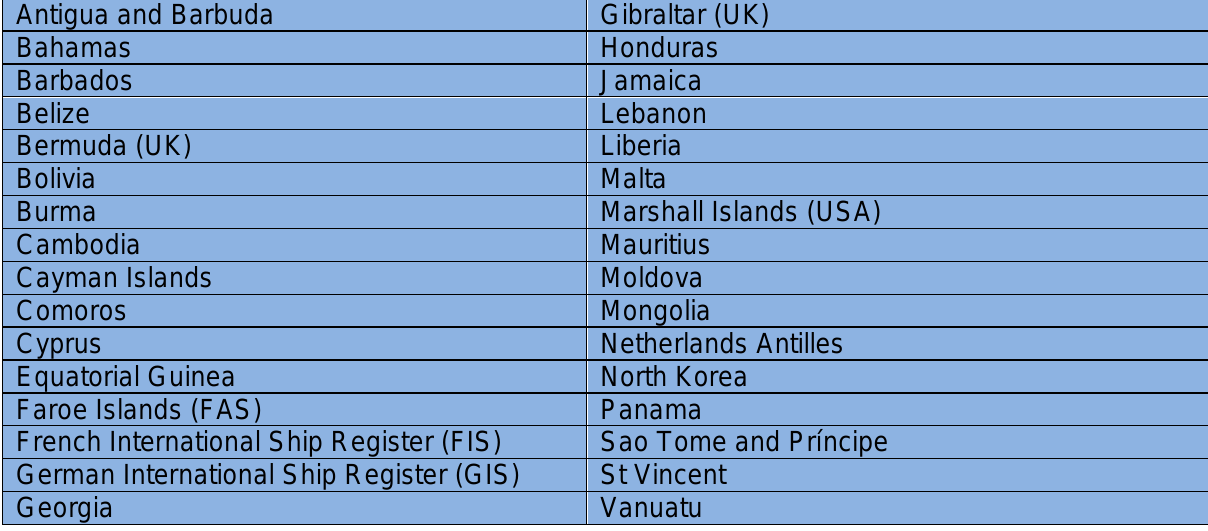
Table 1: Current Flag of Convenience registries, 2011